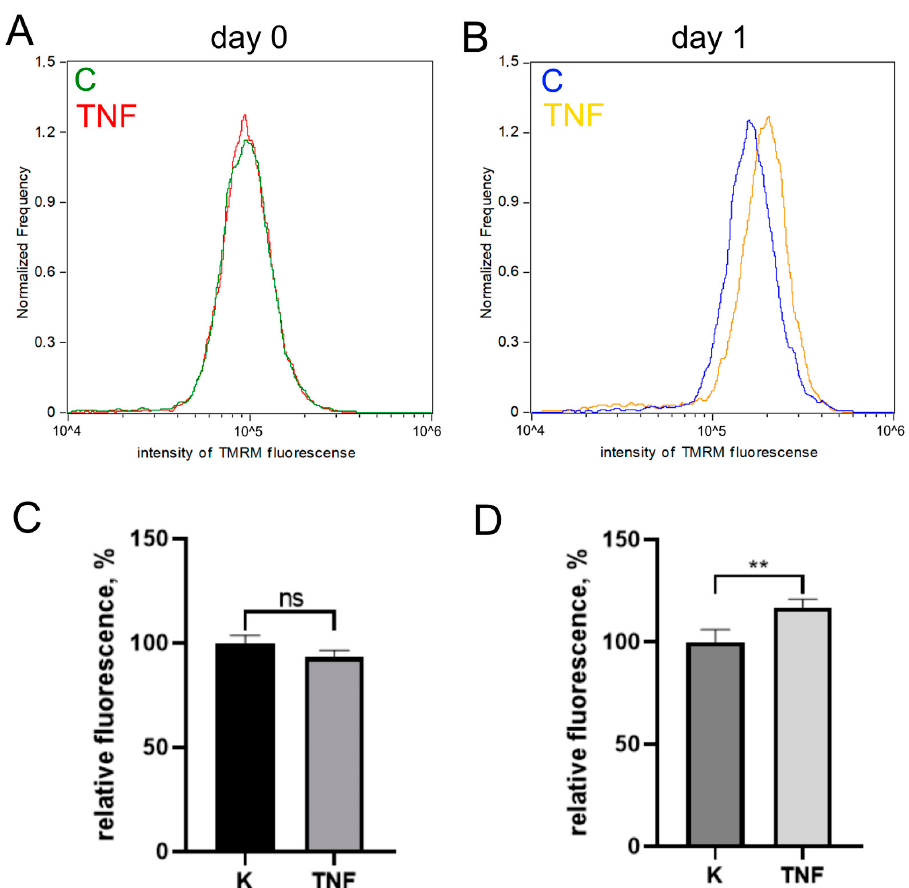
Figure A1. TNF does not cause mitochondrial depolarization. Mitochondrial membrane potential was measured with TMRM using flow cytometry before differentiation induction (day 0) and after 24 h of differentiation (day 1) in control and TNF-treated myoblasts. Typical histograms ( A , B ) and ( C , D ) diagrams showing means of median fluorescence values ( ± SD) expressed as % relative to untreated control. **— p < 0.01, n ≥ 3, ns: no significant